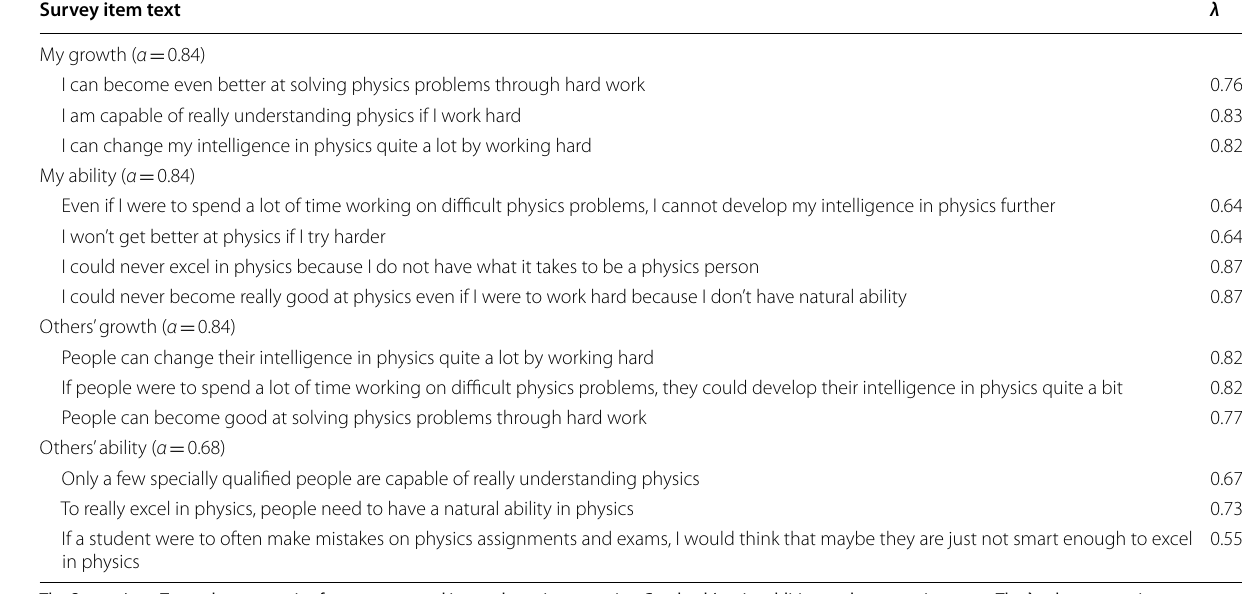
Table 1 Survey items included in the study